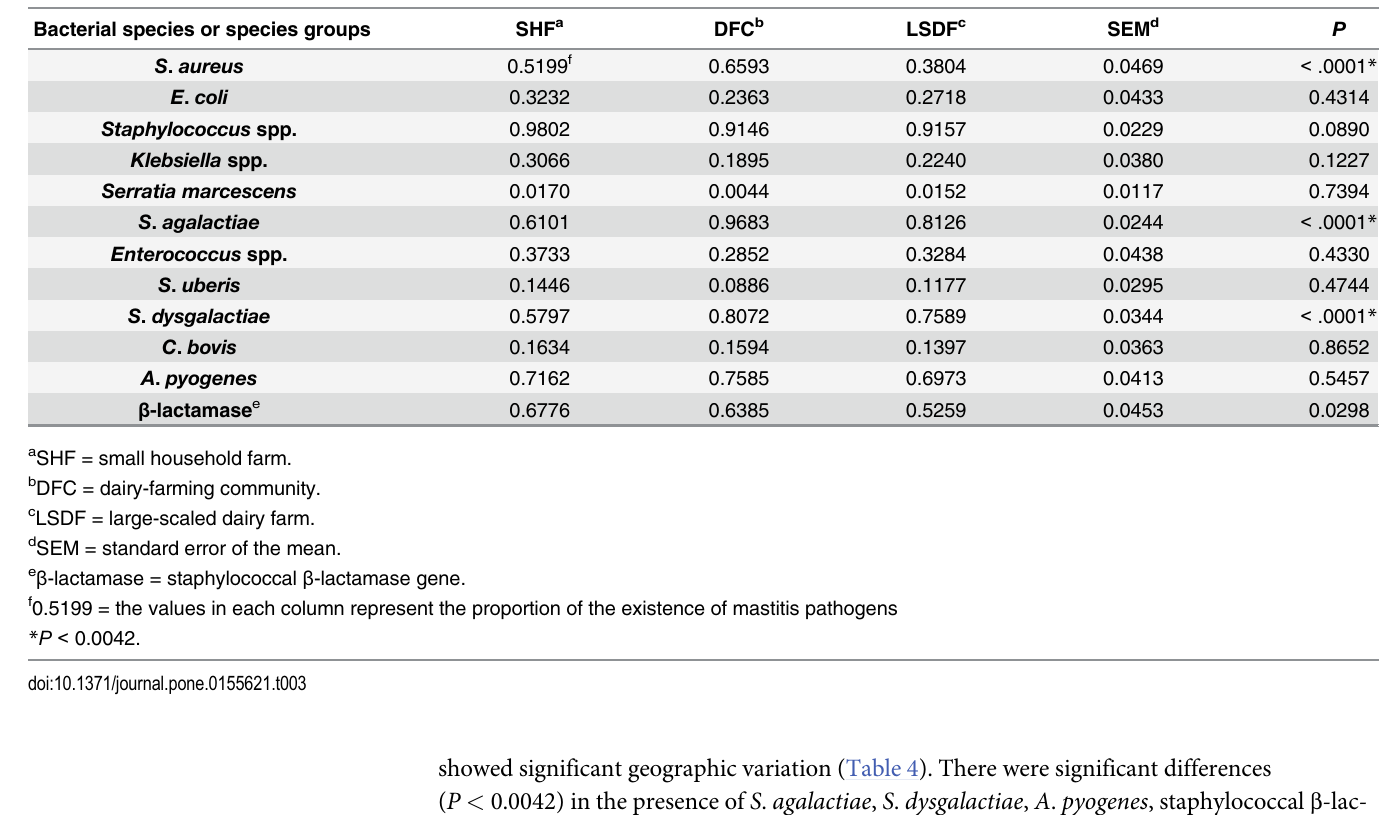
Table 3. Effect of dairy cattle farming modes on the presence of mastitis pathogens. Bacterial species or species groups